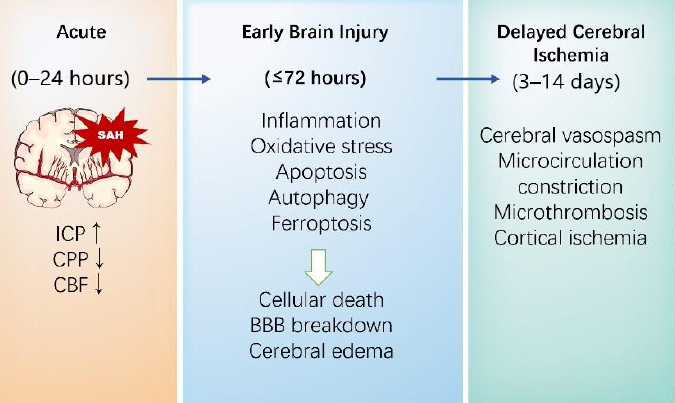
Figure 1. The pathophysiological mechanisms of brain injury following a